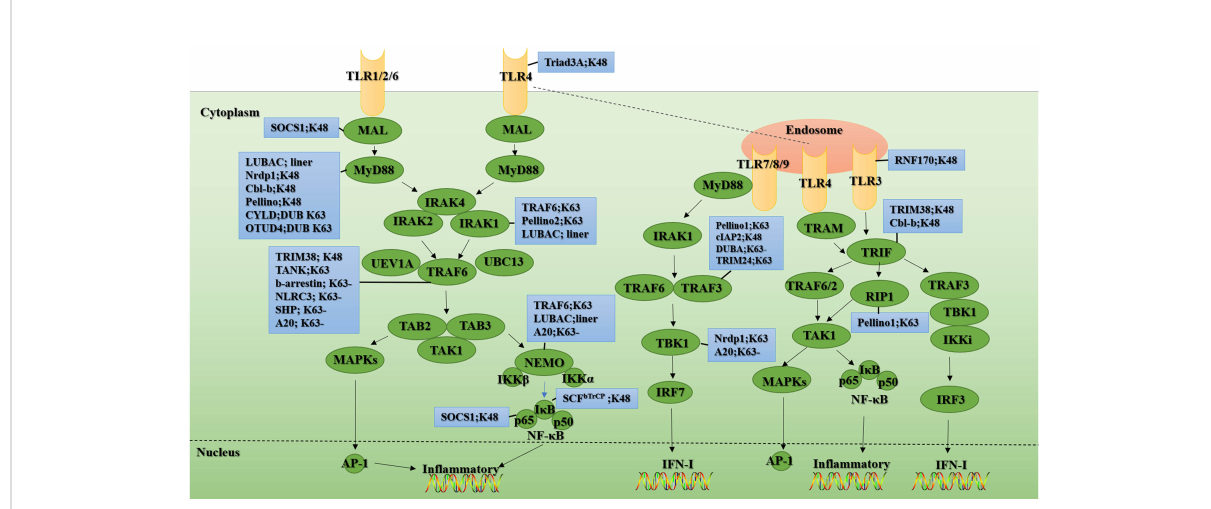
FIGURE 2 Ubiquitination and de-ubiquitination in the TLR signal. Upon ligand recognition, most TLR family members (shown in yellow), except TLR3, recruit the adaptor protein MyD88 and thus initiate a MyD88-dependent pathway involving the signal transduction mediators IRAKs, TRAF6, TAK1, TAB1, and TAB2, ultimately activating NF- k B transcription factors and MAPKs (shown in green), thereby inducing the production of IFN-I and in fl ammatory cytokines. Unlike other TLR family members, TLR3 (shown in yellow) signaling is completely dependent on TRIF (shown in green). This TRIF-dependent pathway mediates not only the production of proin fl ammatory cytokines but also the production of IFN-I upon activation of TLR3 and TLR4. In the blue boxes are the E3s or the DUBs involved in the regulation of this signaling protein. “ - ” means removing. The fi gure is referenced from Figures 1 and 2 of Regulation of Toll-like receptor signaling in the innate immunity